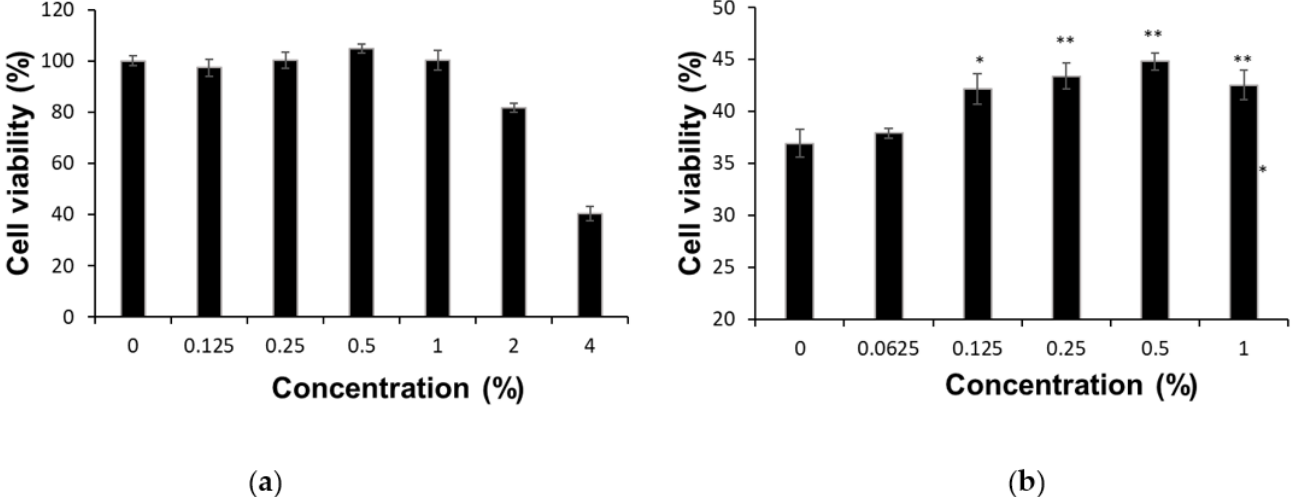
Figure 1. Inhibitory effect of FESCL cell cytotoxicity induced by treatment of Cadmium chloride (4 µ g/mL) in HaCaT cells. ( a ) The cell viability of FESCL in HaCaT cells ( b ) The cell viability of FESCL in HaCaT cells with treatment of Cadmium chloride (4 μg /mL). The data are presented as the mean ± SD of three replicates. * p < 0.05 and ** p < 0.01.